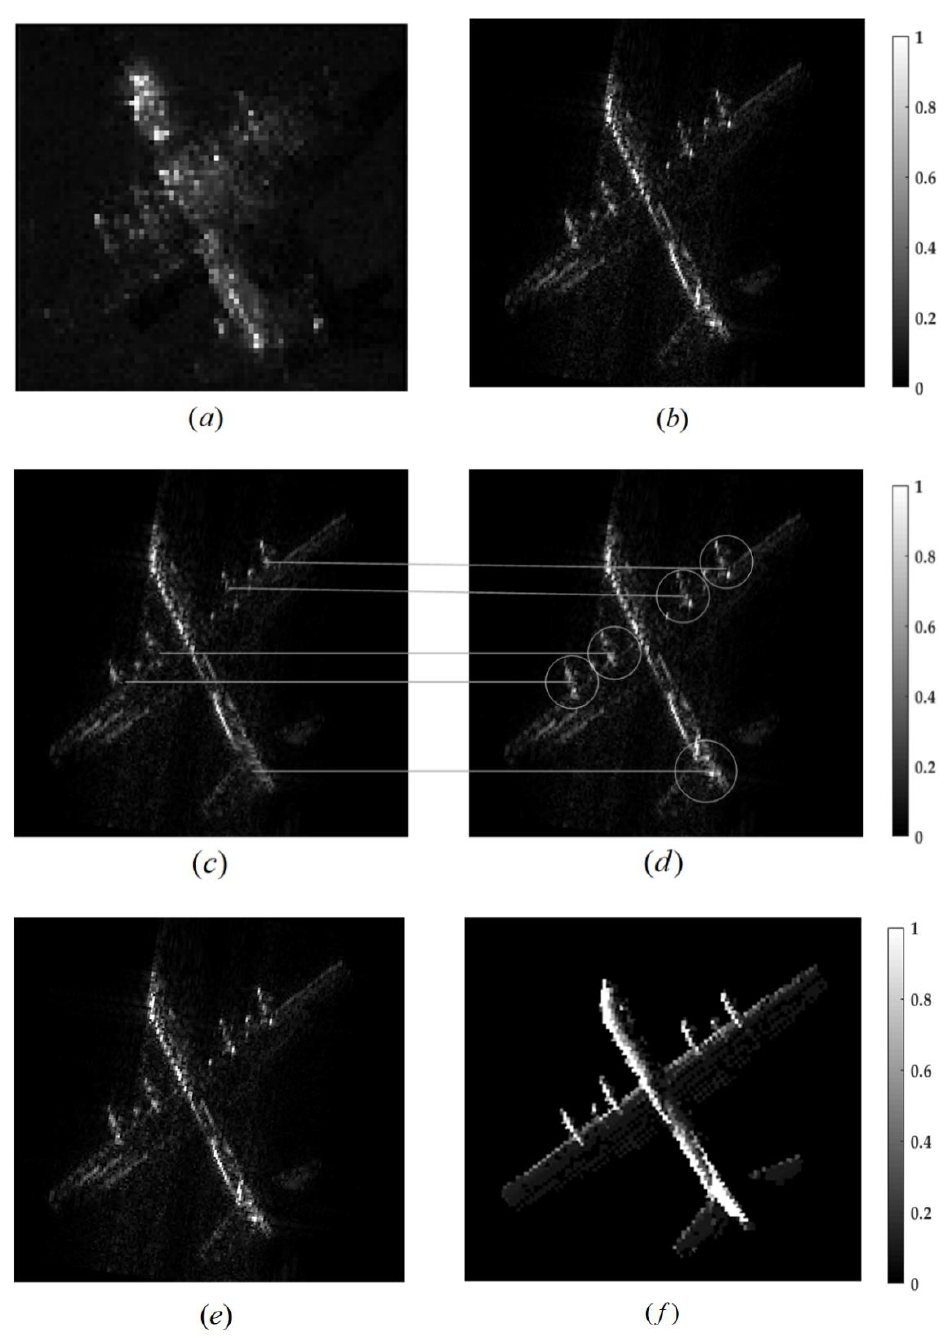
Figure 18. Comprehensive comparison of real SAR image and simulated SAR image: ( a ) real image; ( b ) simulated image include multiple scattering. ( c ) single scattering image. ( d ) multiple scattering distribution image. ( e ) simulated SAR image using the method we proposed ( f ) simulated SAR image using geometric feature-based RaySAR's simulation method.